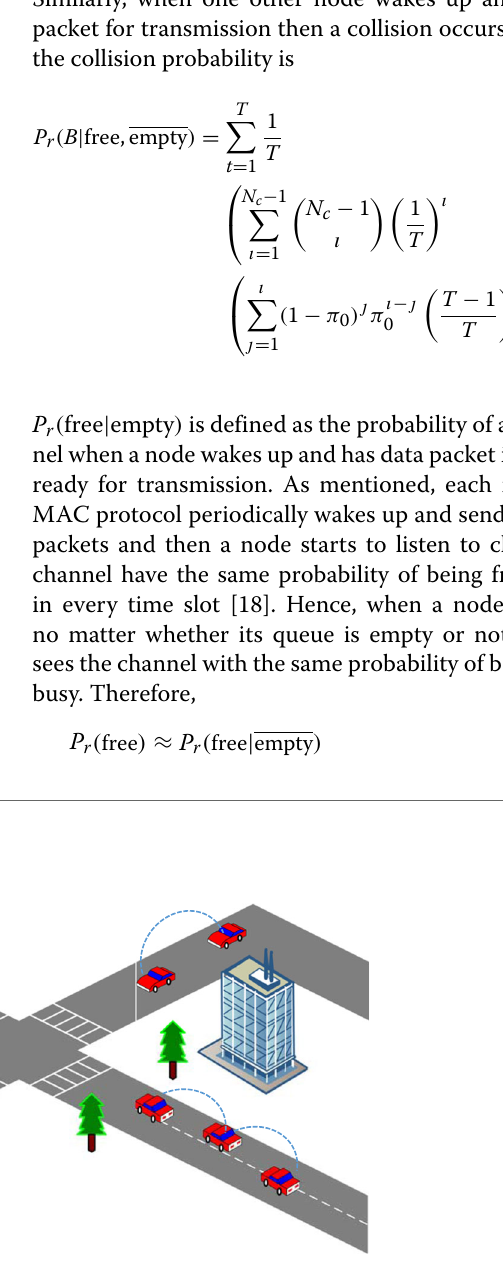
Fig. 6 Network topology to evaluate the X-MAC